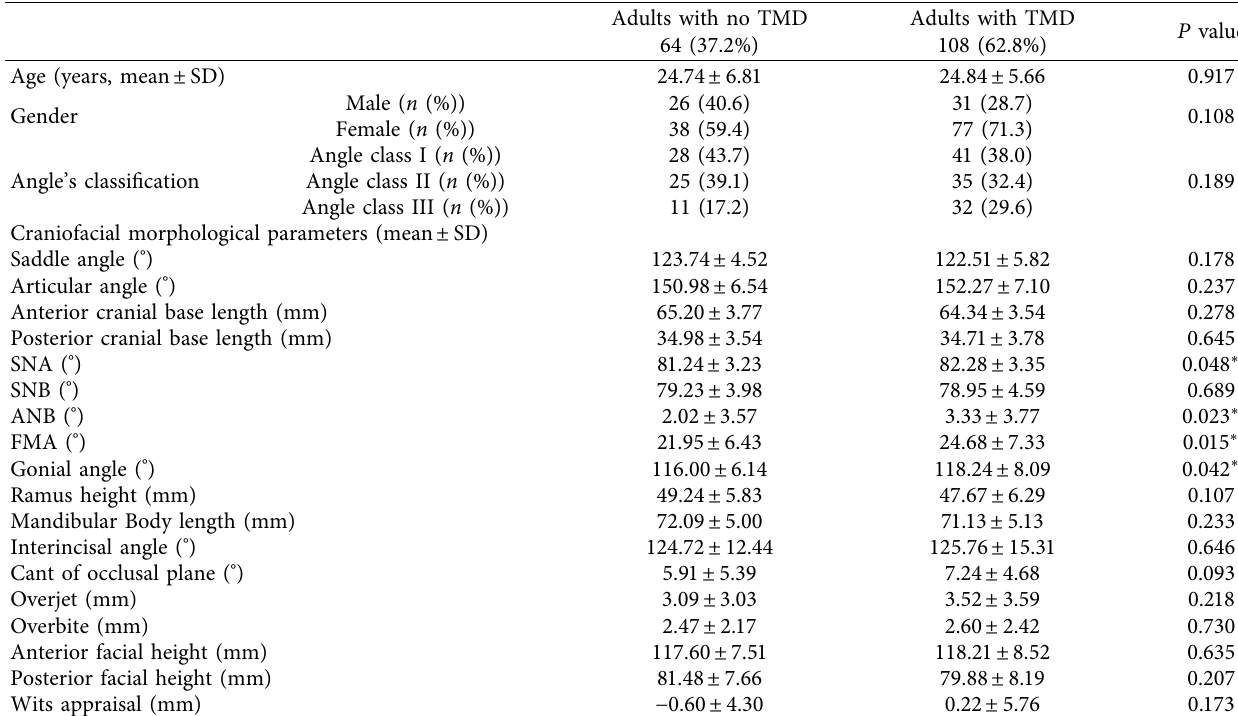
Table 5: Comparison of demographic, occlusal, and craniofacial morphological characteristics between adult patients (aged 18 years or above) with and without